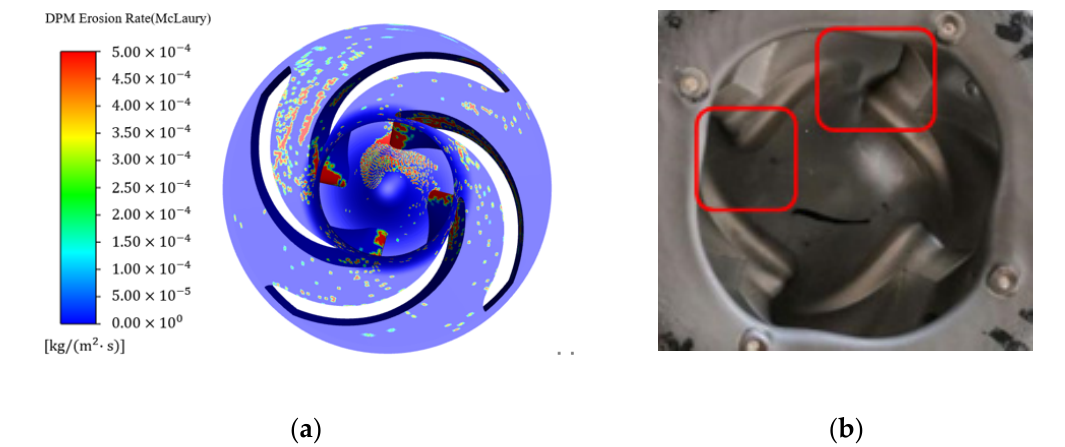
Figure 6. Wear comparison at impeller inlet: ( a ) simulation; ( b ) experiment.